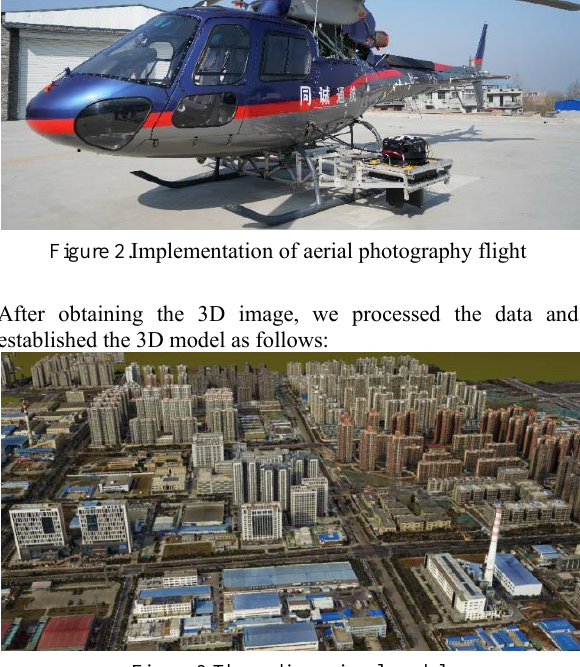
Figure 1.Work flow chart